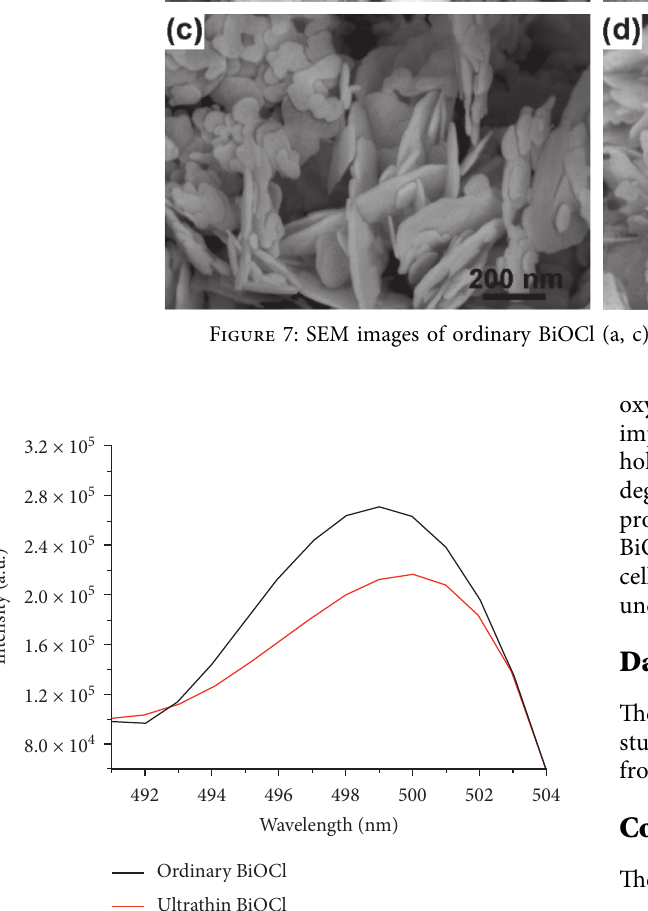
Figure S1: the absorption spectra for the degradation of